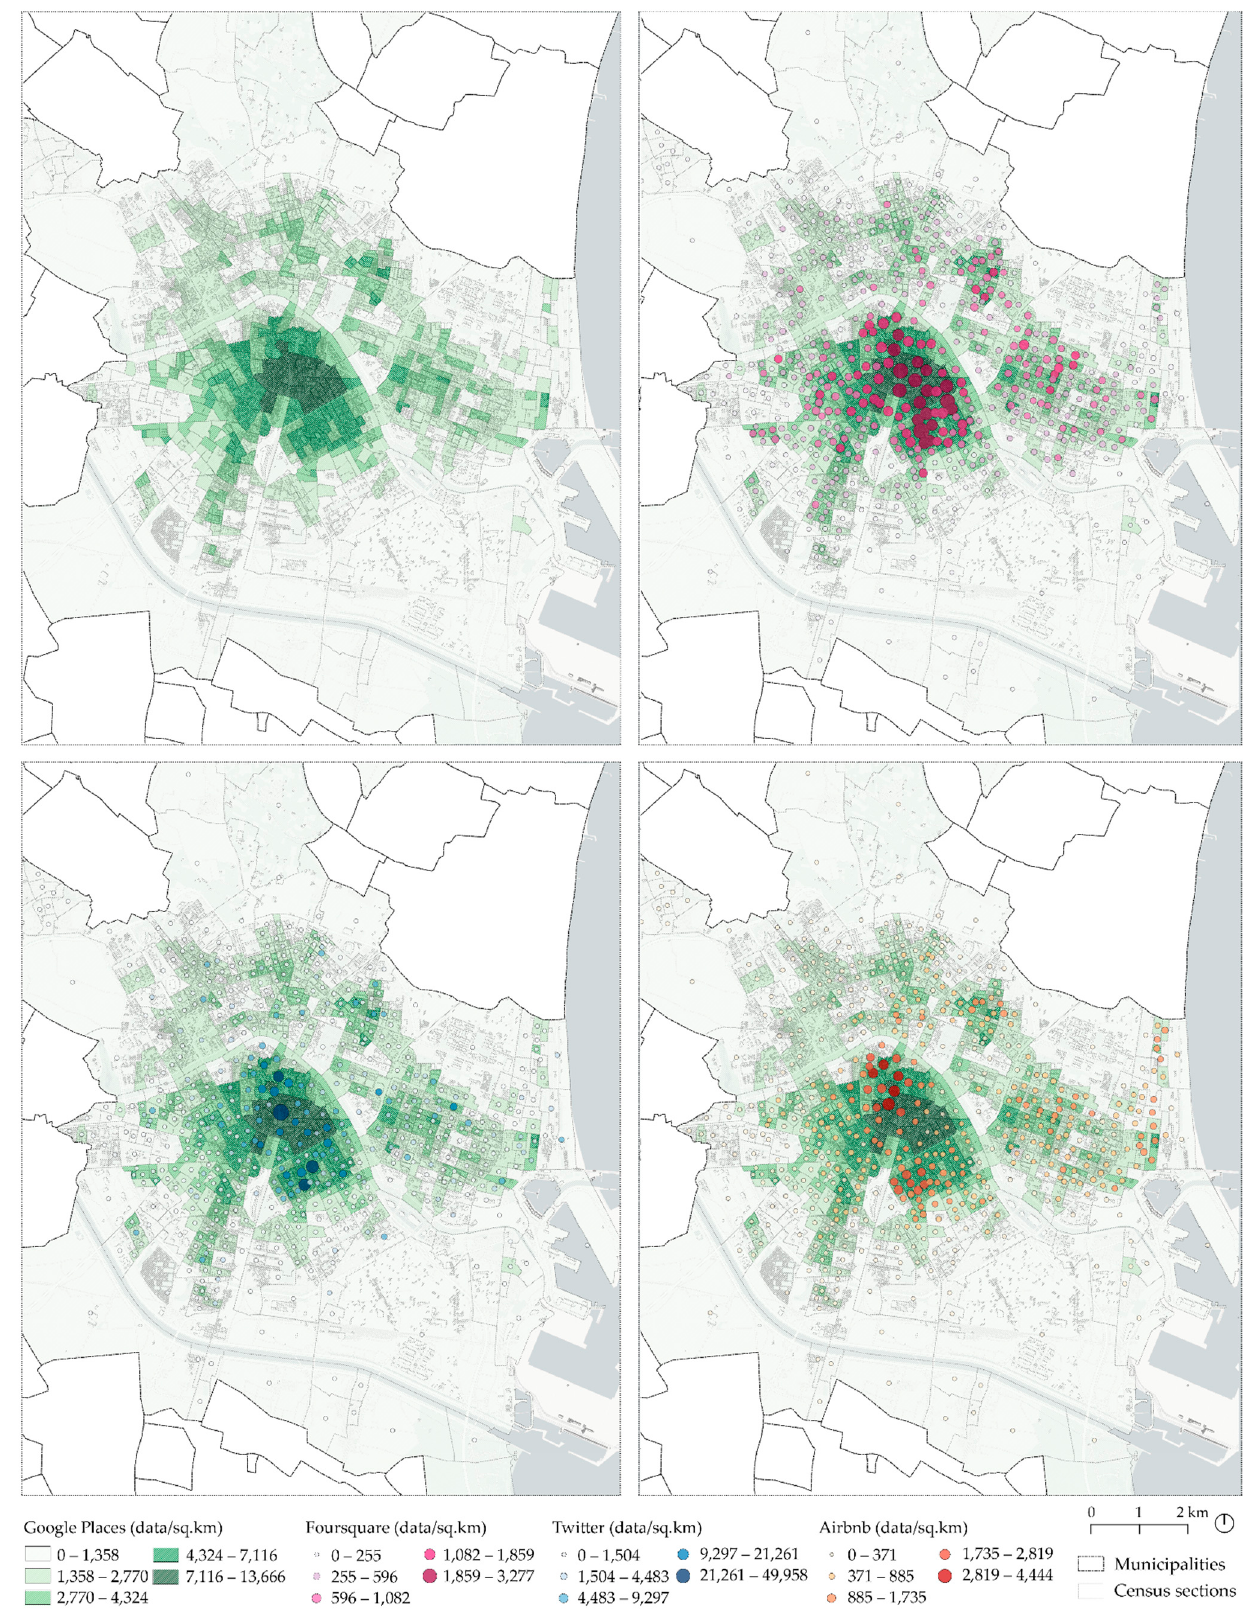
Figure 13. Google Places (economic activities) data density and Foursquare, Twitter and Airbnb data density.